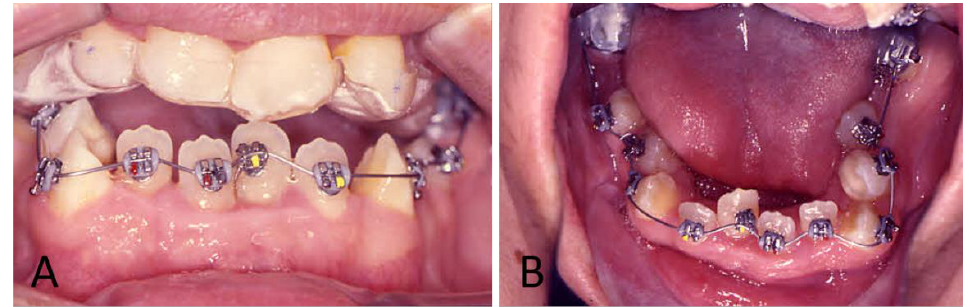
Figure 5. To start the treatment, an upper mouthguard ( A ) and lower bracket direct bonding and a 0.016” NiTi archwire ( B ) were placed.